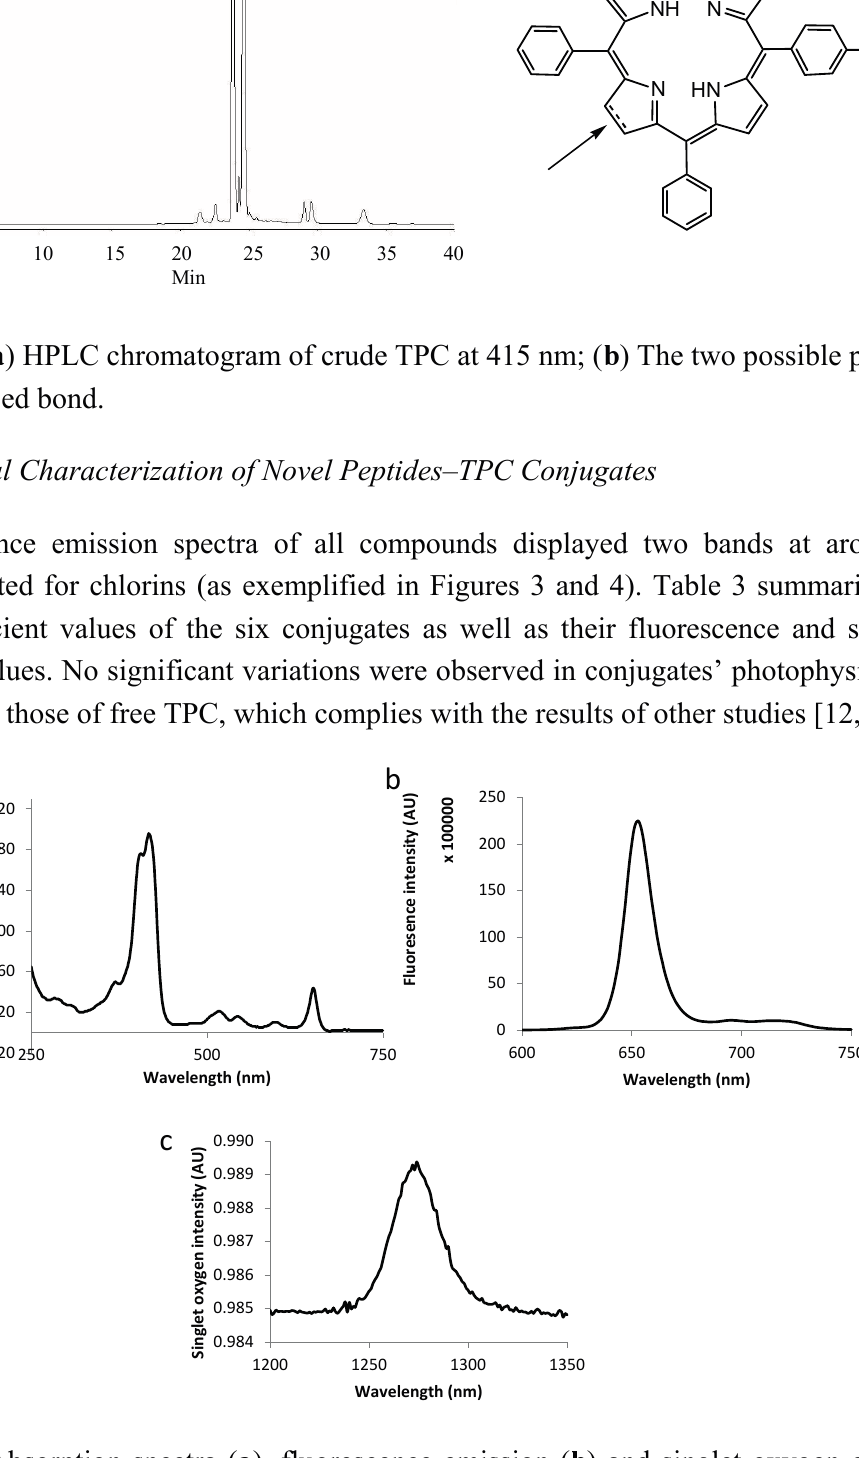
Figure 3. Absorption spectra ( a ), fluorescence emission ( b ) and singlet oxygen emission spectra ( c ) for TPC–PEG18–DKPPR in